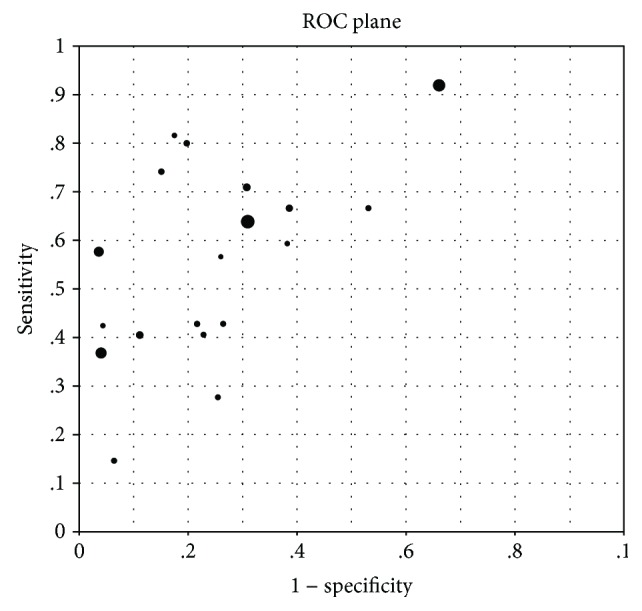
ROC scatter plot.